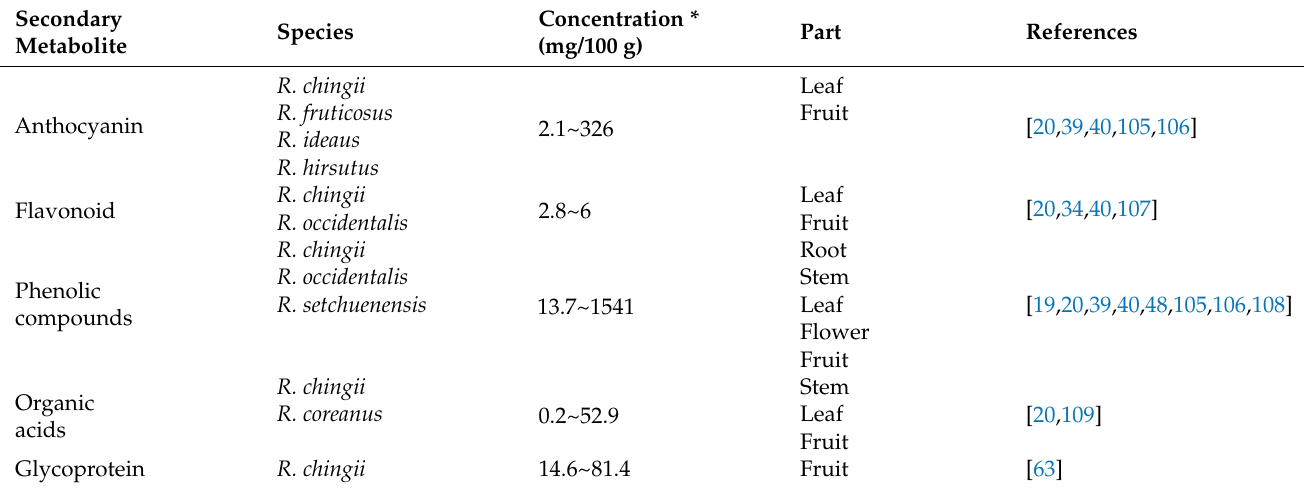
Table 1. Major secondary metabolites of Rubus